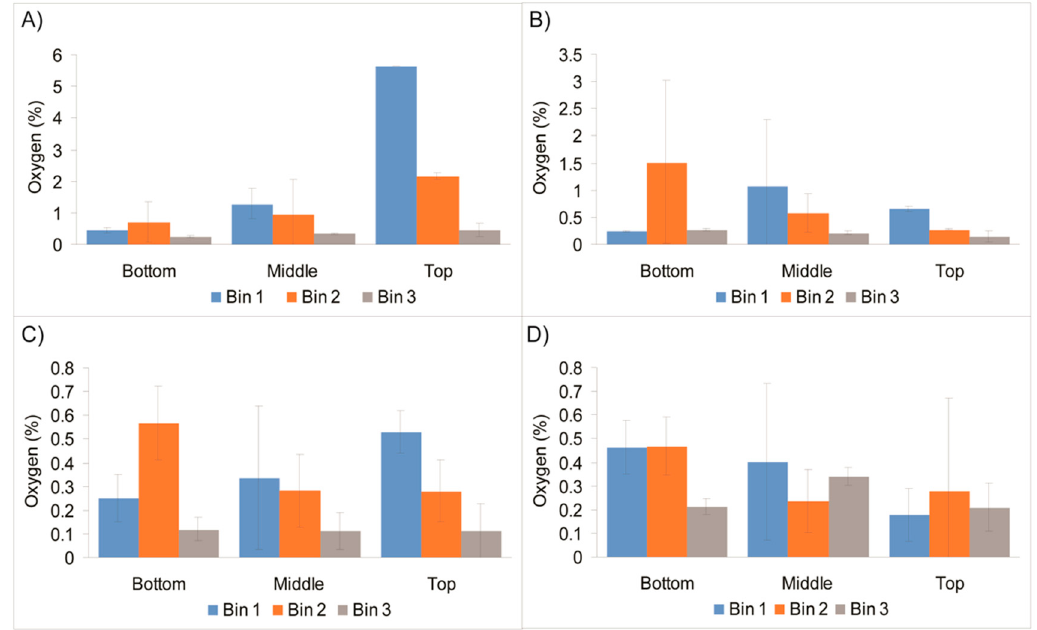
Figure 3. Comparison of mean O 2 readings in top, middle, and bottom parts of Bins 1, 2, and 3, measured on Day 1 ( A ), Day 3 ( B ), Day 11 ( C ), and Day 15 ( D ).